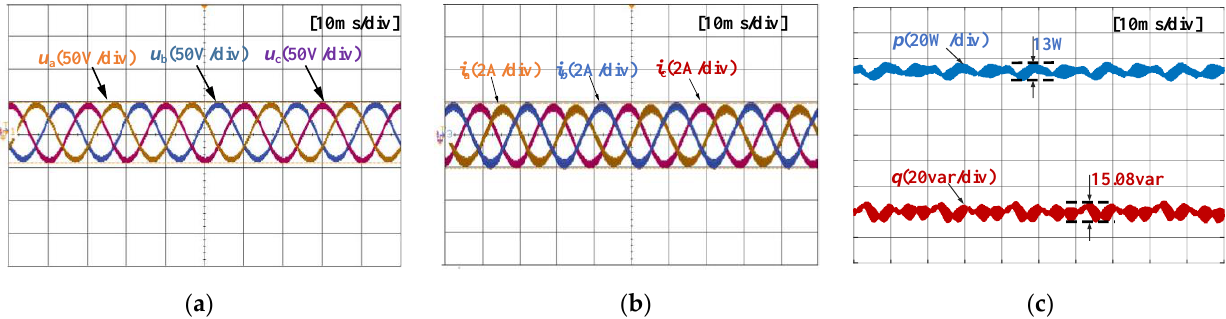
Figure 15. Experimental results of the modified topology, when V b drops to 0.5 p.u. ( a ) Output voltage at PCC 1 ; ( b ) output current; ( c ) output active power and reactive power.